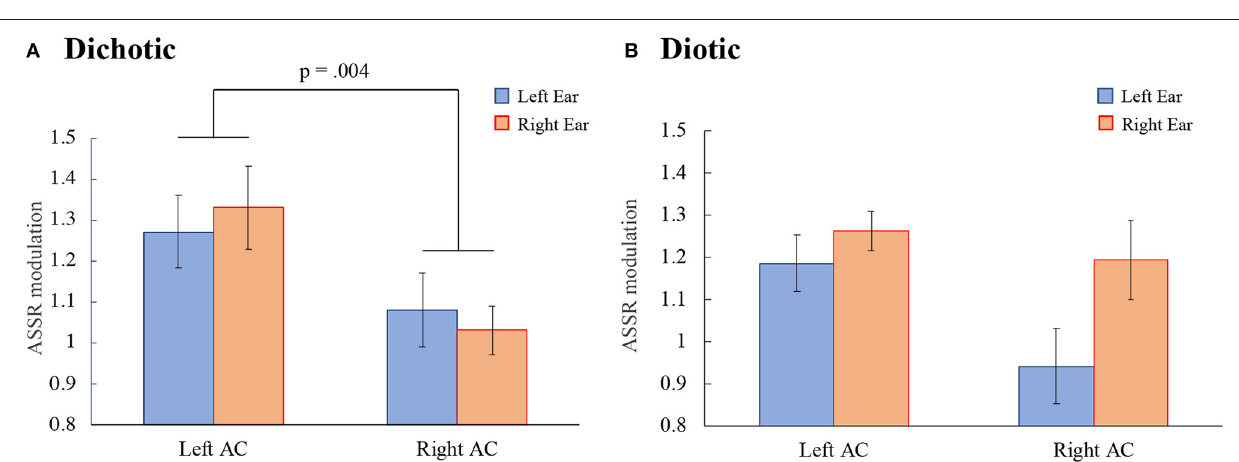
FIGURE 4 | The ASSR modulations in the left and right auditory cortex (Left AC or Right AC) to the left and right ears during the dichotic (A) and the diotic (B) listening tasks. Error bars indicate standard error of the mean. ASSR, auditory steady-state response; AC, auditory